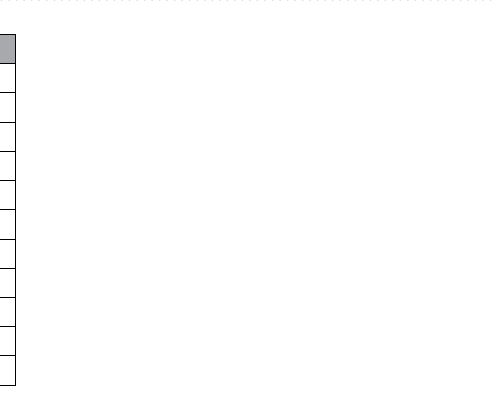
Figure 4. Serial optical coherence tomography angiography images and vessel density of superficial capillary plexus ( A–D ) and deep capillary plexus ( E–H ) of bevacizumab group, and superficial capillary plexus ( I–L ) and deep capillary plexus ( M–P ) of PRP group.